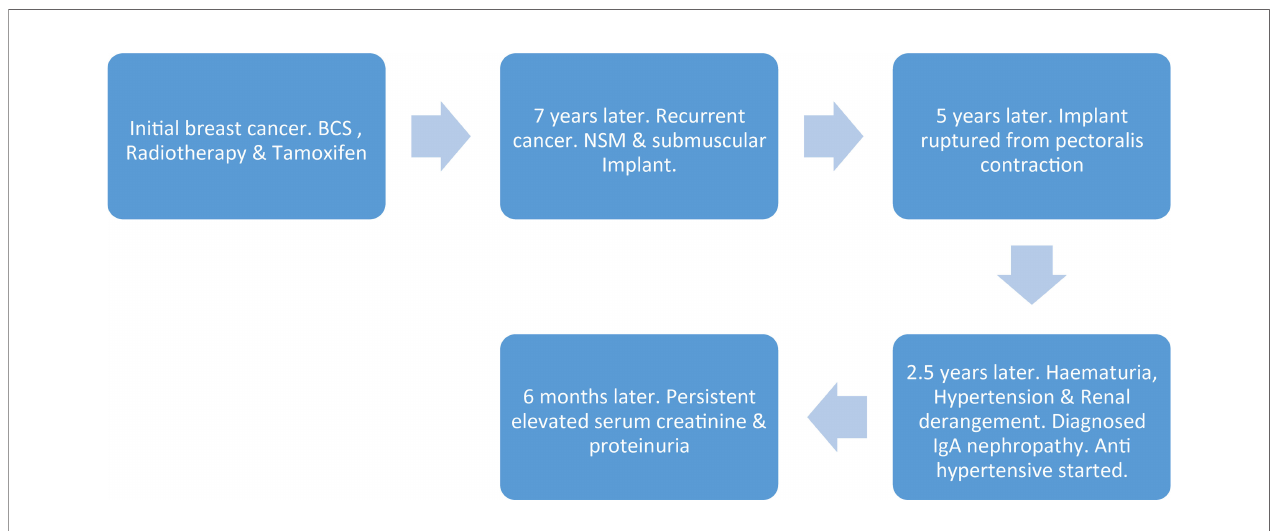
FIGURE 3 | Timeline of events. BCS, breast-conserving surgery; NSM, nipple-sparing